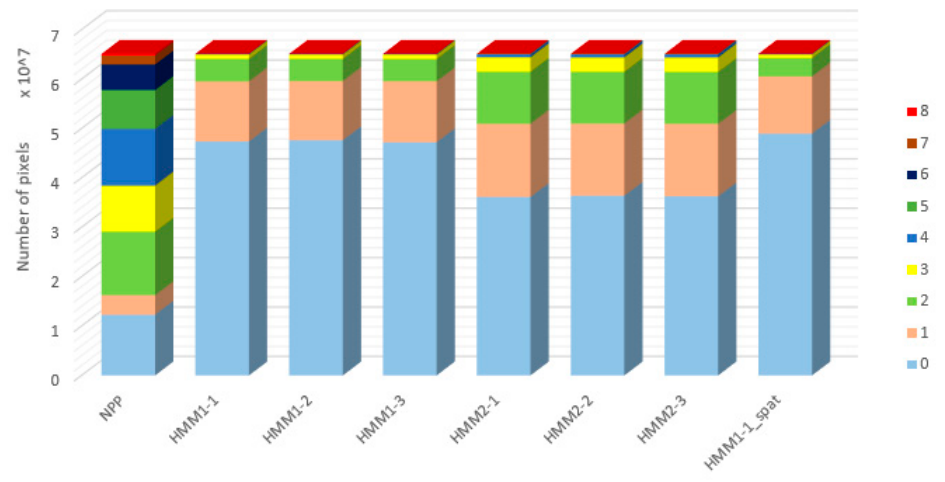
Figure 6. 100% stacked bar chart showing the number of label changes for pixels, 2007–2015.